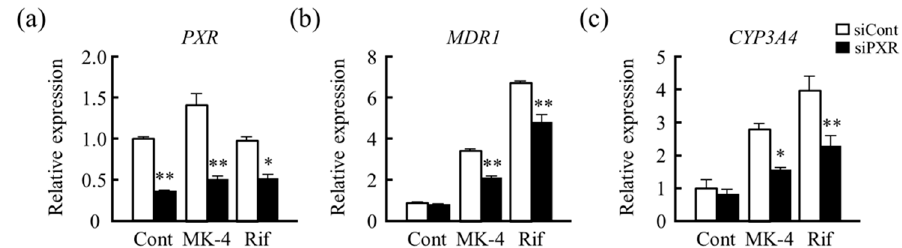
Figure 3. Effect of PXR knockdown on drug metabolism-related genes. To investigate the regulation of PXR in drug metabolism-related gene expression induced by menaquinone-4 (MK-4), the effect of siRNA-mediated knockdown of PXR on the mRNA levels of ( a ) PXR , ( b ) MDR1 , and ( c ) CYP3A4 after 24 h of MK-4 treatment was analyzed. The effect was compared with that of rifampicin (Rif) treatment. Relative mRNA levels were normalized to those of eukaryotic translation elongation factor 1 α 1 mRNA. Data are expressed as the mean ± standard error of the mean, n = 3, * p < 0.05, ** p < 0.01 vs. control (siCont). PXR , pregnane X receptor; MDR1 , multi-drug resistance; CYP3A4 , cytochrome P450 3A subfamily 4.